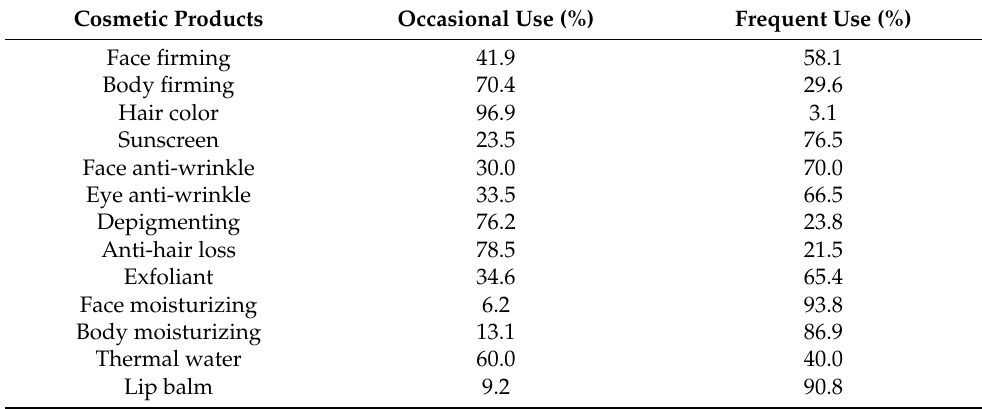
Table 1. Usage patterns of cosmetic